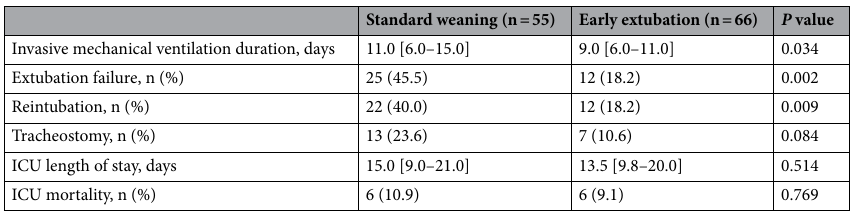
Table 2. Clinical outcomes. Data are presented as number and percentage of patients (in brackets) or median and interquartile range [in brackets]. ICU, intensive care unit. P values refer to Fisher’s exact test or Mann– Whitney